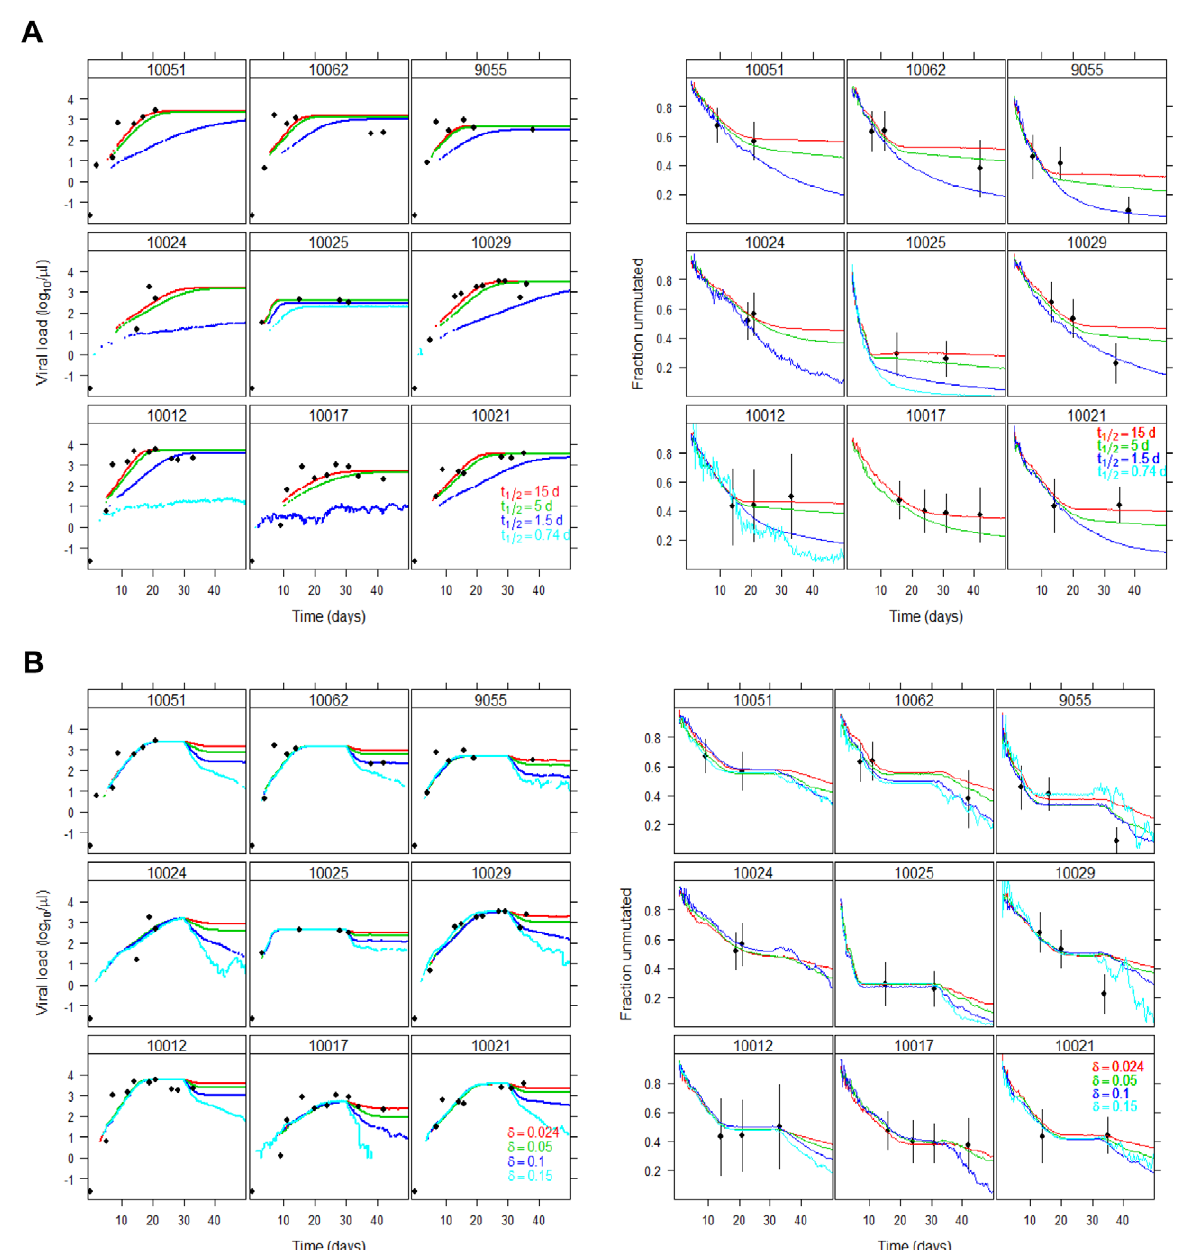
Figure 4. Changes in viral load and mutation profile predicted by the model. (A) different values for the half-life of replication complexes (ln 2/ r ), and (B) the emergence of a cytolytic immune response at 30 days post-infection. Note that if there were less than 5 runs leading to establishment of infection, no line is plotted, because the noise is too large. Thus in (A) for short half-life of replication complexes (i.e., t 1/2 =0.74 d in cyan) the line may not appear, because the infection was not established, or the line may disappear, because an initial infection was